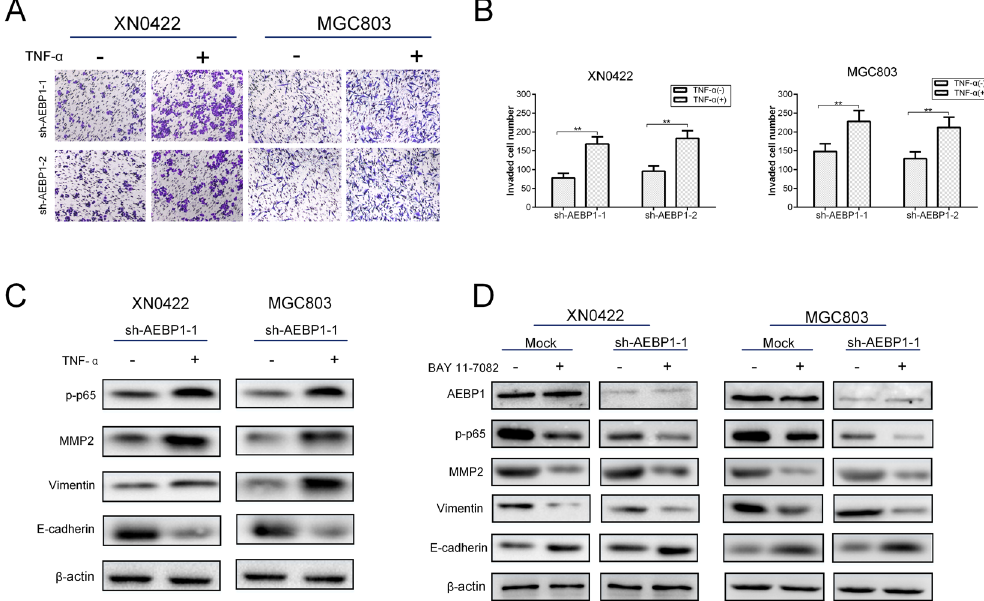
Figure 7. AEBP1 modulates epithelial-mesenchymal transition of gastric cancer cells by functioning as an important upstream regulator of the NF- κ B pathway. ( A ) Representative images of transwell invasion assays showing TNF- α (10 ng/mL) treatment significantly reversed the impaired invasive capabilities due to knockdown of AEBP1; magnification: 200 × . ( B ) Quantification of the transwell invasion assay